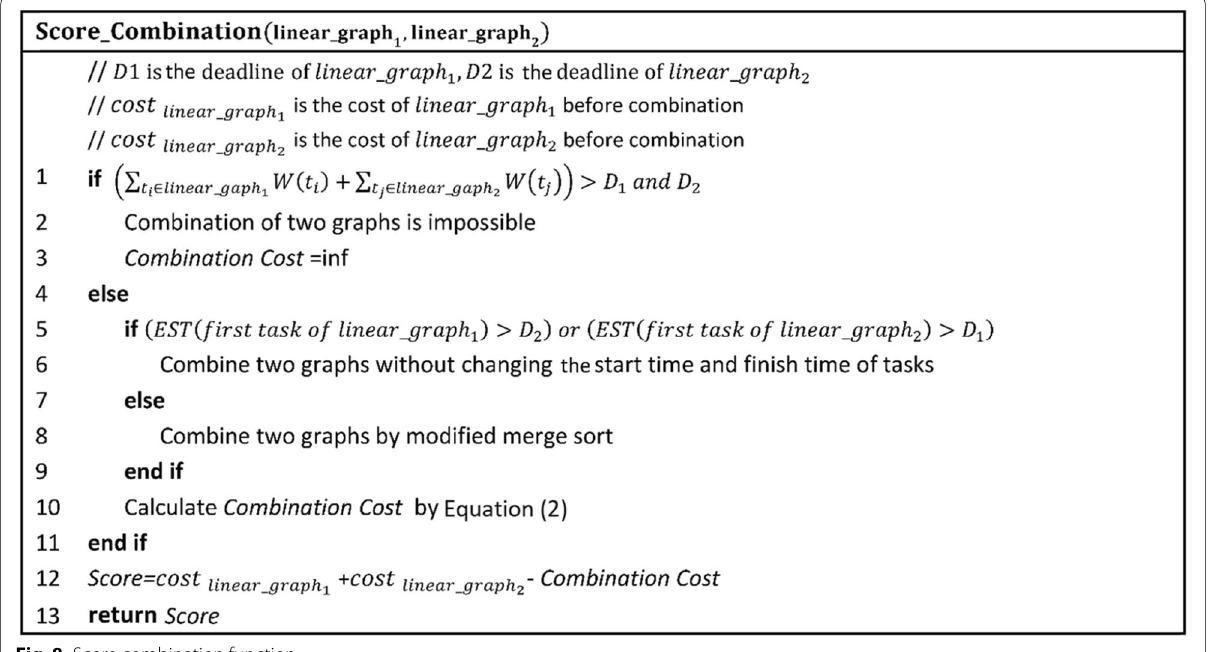
Fig. 8 Score combination